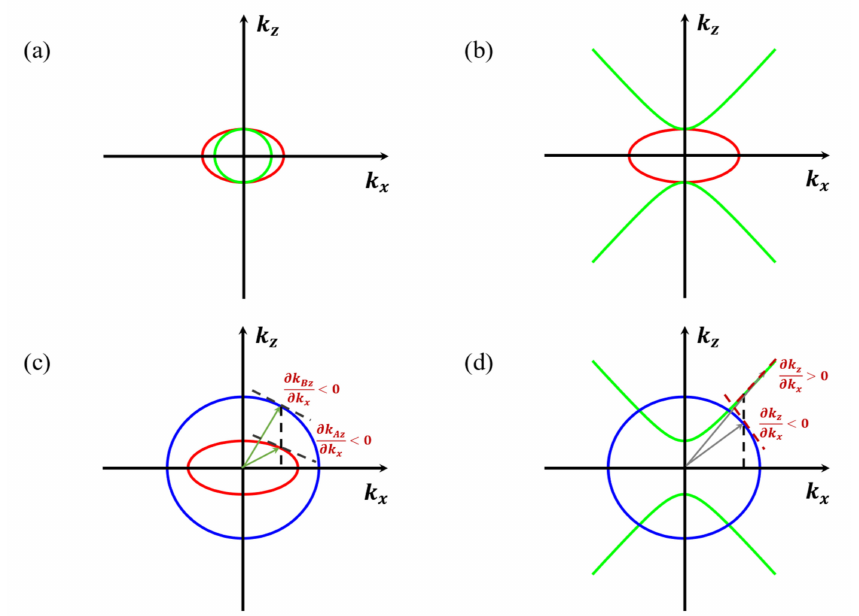
Figure 3. Iso-frequency curves of ACMs for RCP and LCP waves at ( a ) κ = 0.05 and ( b ) κ = 1.05. Iso-frequency curves of ACMs and silicon for ( c ) RCP and ( d ) LCP waves at λ = 532 nm. The real part of the refractive index of silicon is 4.08, as taken from Figure 2c. Red and green solid lines represent the iso-frequency curves of ACMs for RCP and LCP waves, respectively. Blue solid line represents the iso-frequency curves of dielectrics for RCP and LCP